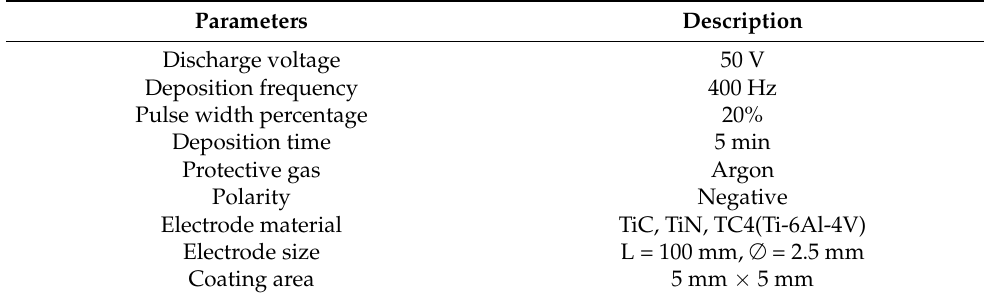
Table 5. ESD comparative experiment conditions.